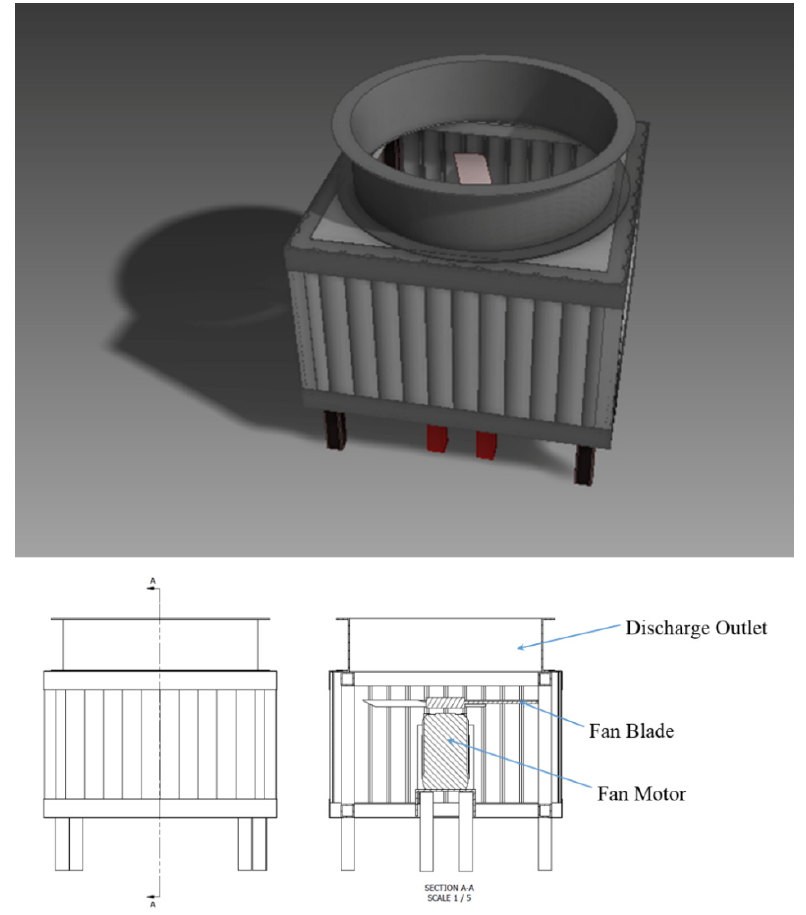
Figure 2. Perspective, side, and cross-section view of the cooling tower